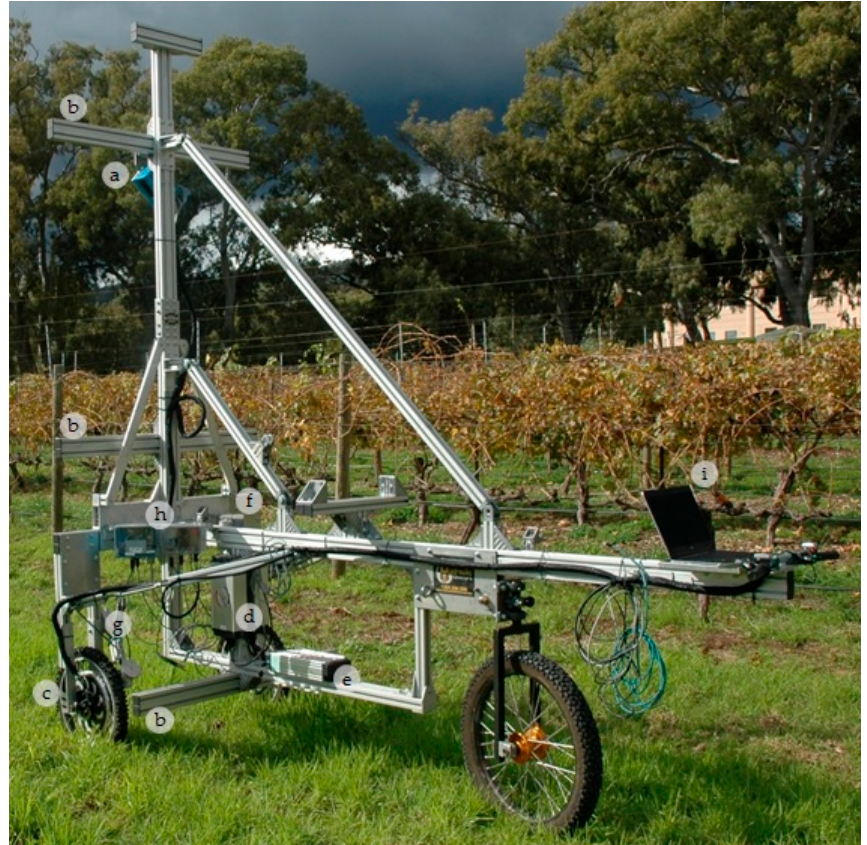
Figure 1. This shows GRover’s frame and components: ( a ) is the SICK LMS-400 light radar (light detection and ranging, LiDAR), mounted 2.25 m above the ground at a 45-degree angle. The LiDAR scans at 250 Hz at a wavelength of 650 nm and a range of 3 m; ( b ) shows the masts on which instruments can be mounted—each mast can be moved up, down, away from or toward the frame; ( c ) each of the front wheels contained an electric motor; ( d ) shows the 48v batteries used to power the wheels; ( e ) is the 24v instrument battery which was split into separate voltages by ( f ) the junction box; ( g ) is the spring-armed wheel encoder, which tracked the linear distance travelled during scans; ( h ) the data from the LiDAR, encoder and Global Positioning System with Inertial Measurement Unit (GPS/IMU), which was attached to the top of the LiDAR, were relayed back to ( i ) the field laptop. The frame was equipped with three wheels: the front two wheels have built-in electric motors, and there was one free-pivoting wheel in the rear. The rear tire allows GRover to have a zero degree turn radius, which was important to enable manoeuvrability in looping between vineyard rows. The wheels were operated and driving speed was controlled by two thumb-throttle controllers mounted on GRover’s rear handle